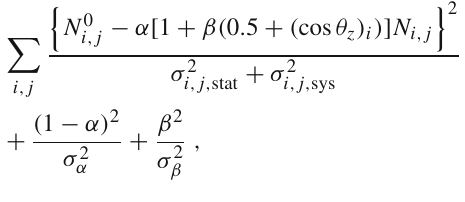
Fig. 3 The same as Fig. 1 but for the case (b) shown in Table 1